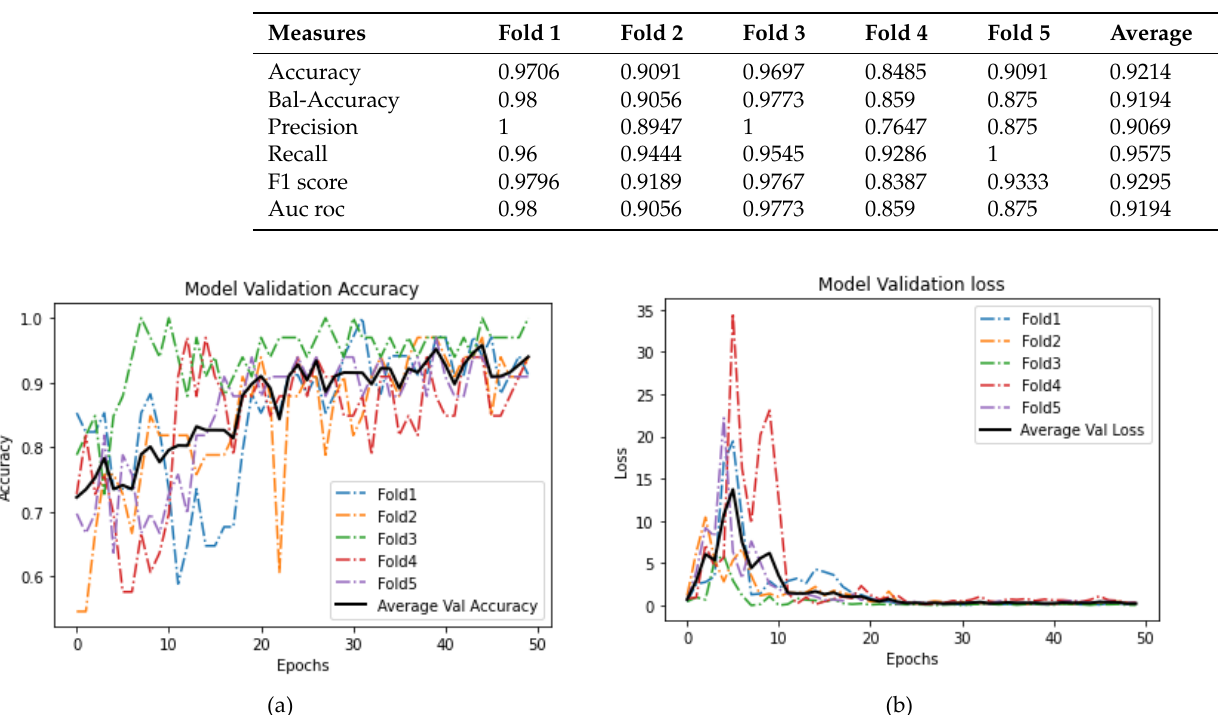
Figure 6. Validation accuracy and loss curve for Xception . (a) Model Validation Accuracy; (b) Model Validation Loss. Validation